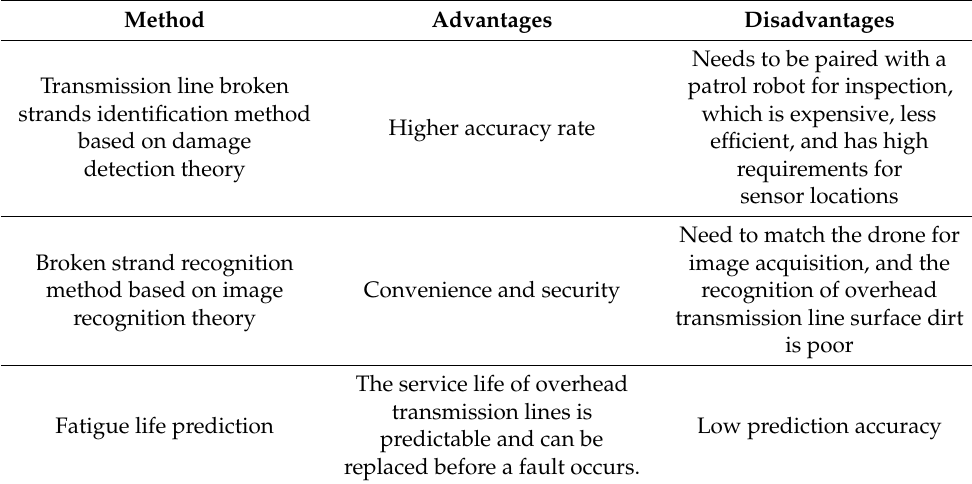
Table 1. Comparison of identification methods of overhead transmission